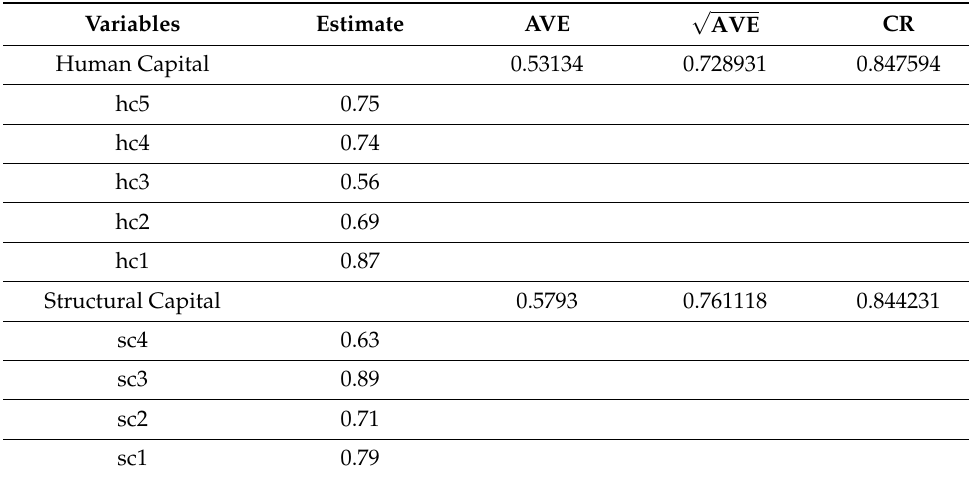
Table 7. Factor analysis of principal